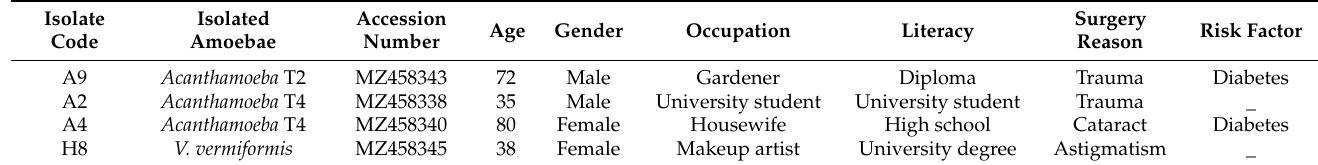
Table 3. Demographic and risk factors of people living in houses positive for FLA.